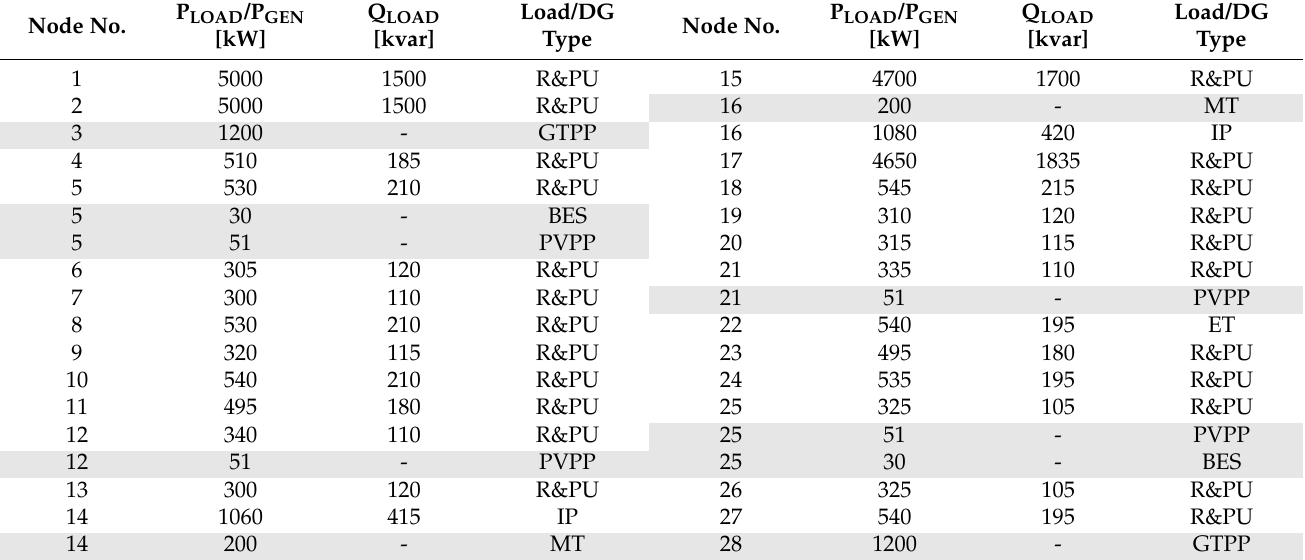
Table A1. Distributed generation sources and energy consumers connected to the urban MV distribu- tion network.